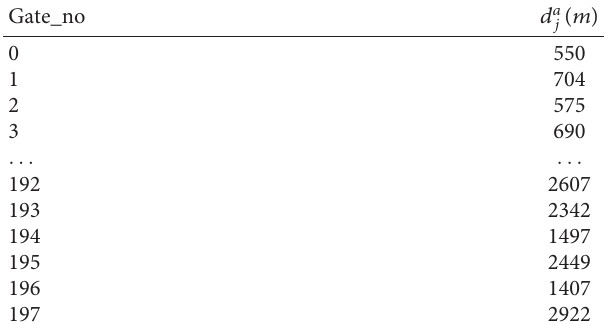
Table 8: Passenger travel distance from gate j to baggage claim area. Gate_no